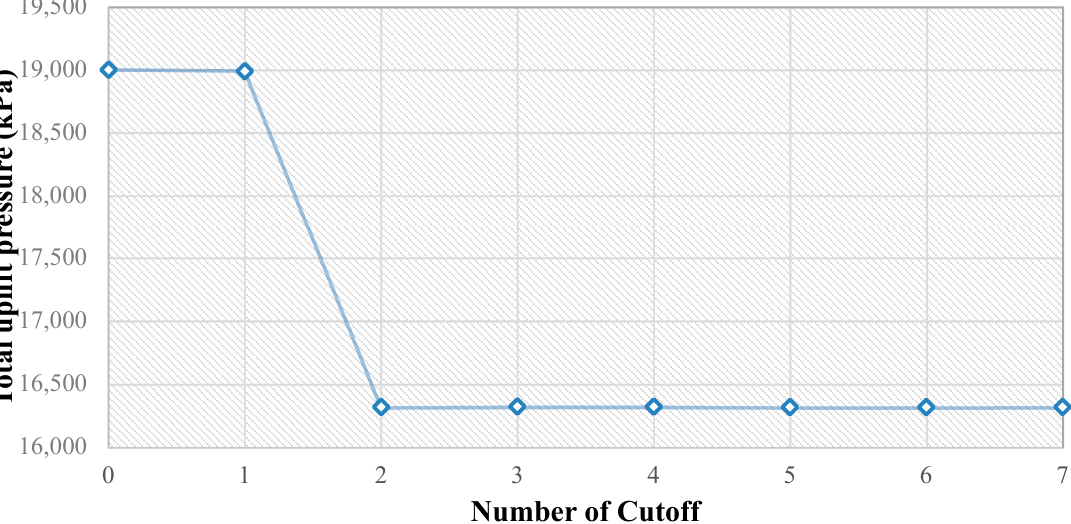
Figure 15. Uplift pressure under the core for different numbers of grout curtains under the dam.